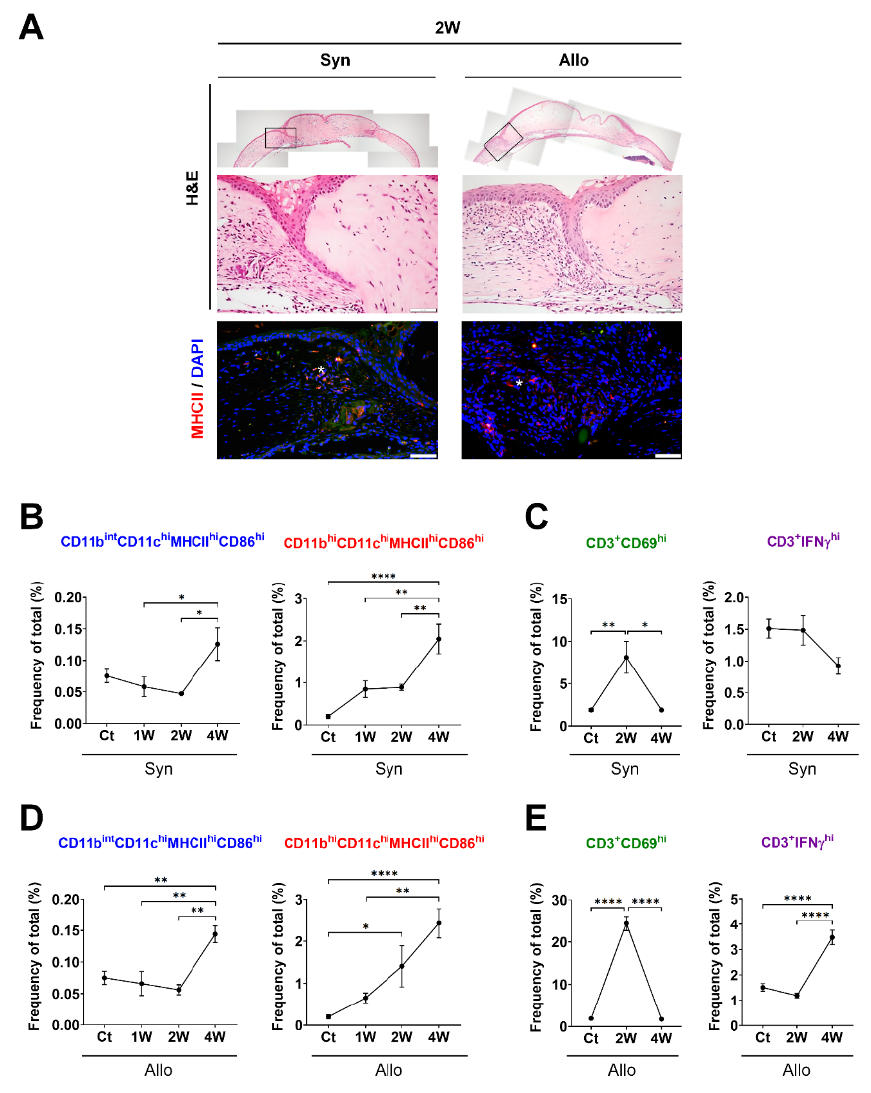
Figure 3. Time-dependent serial changes in APC subsets and T cells in the ocular surface in response to potent sterile inflammation or allogenic immunization up to 4 weeks. ( A ) Representative photographs of hematoxylin–eosin (H&E) and the MHCII immunofluorescent staining of the cornea. The MHCII-expressing cells (red fluorescence, w hi te asterisk) were found in the stromal layer near the graft junction of both the Syn and Allo groups (scale bars: 50 µ m). ( B – E ) Time-dependent frequency changes (% of total) in the CD11b int CD11c hi MHCII hi CD86 hi and CD11b hi CD11c hi MHCII hi CD86 hi subsets and T subsets over 4 weeks in either the Syn or Allo group. The frequencies of both APC subsets increased in the Syn and Allo group over time with a priming of only CD69 hi T cells in the Syn group and both the CD69 hi and IFN γ hi T cells in the Allo group. n = 5 for each time point and n = 12 for Ct; either parametric ANOVA followed by Bonferroni’s post hoc analyses or a non-parametric Kruskal–Wallis test followed by Dunn’s post hoc analyses was selected, depending on the normal data distribution. * p < 0.05, ** p < 0.01 and **** p < 0.0001. Ct indicates the control group; Syn, the syngeneic corneal transplantation group; and Allo, the allogeneic corneal transplantation group. Abbreviations: APC, antigen-presenting cell; IFN γ , interferon